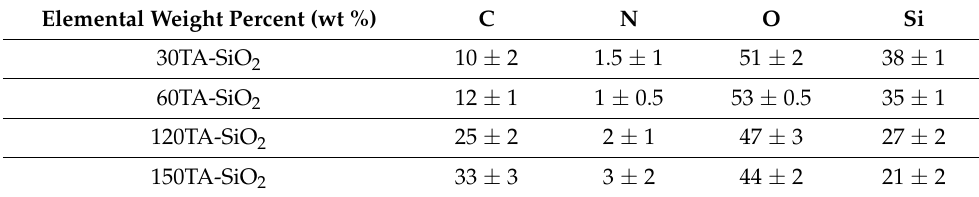
Table 2. Elemental weight percent with standard deviation of the samples determined by EDS. Elemental Weight Percent (wt %)